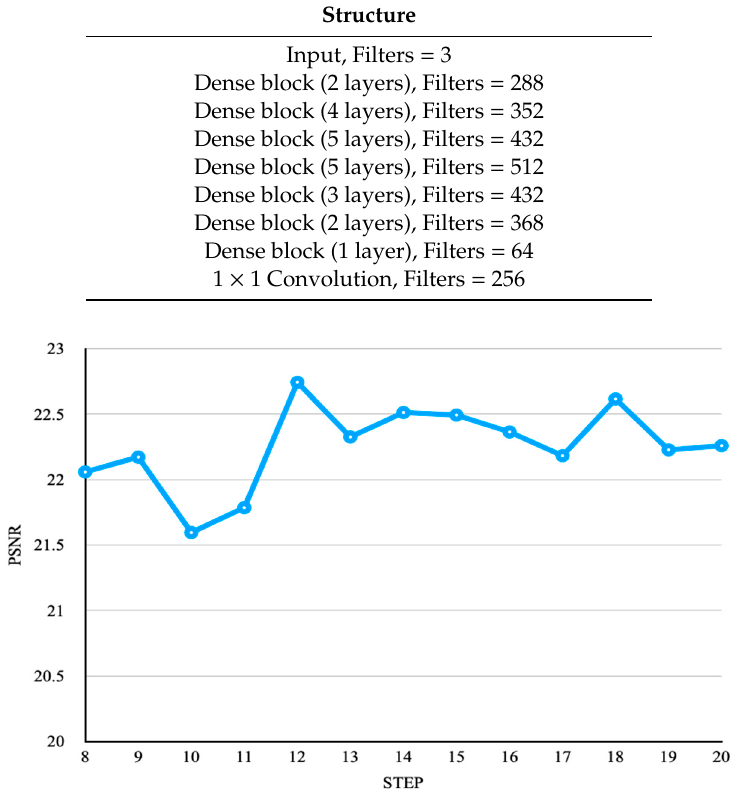
Figure 5. Peak signal to noise ratio (PSNR) score of every 1000 steps.